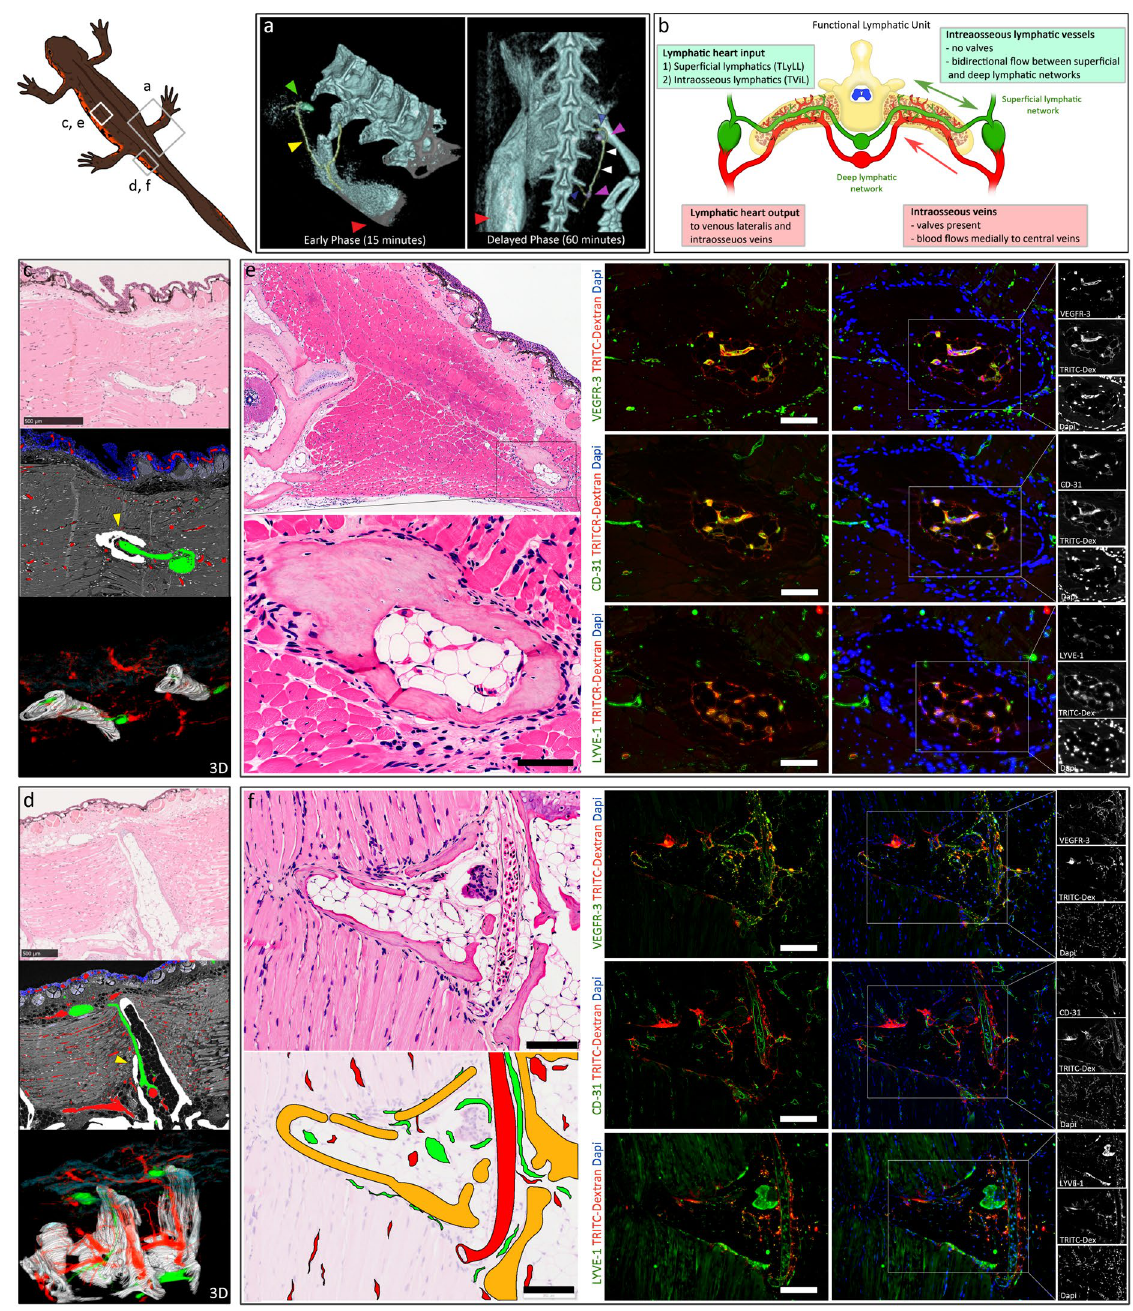
Figure 3. Newt microcirculation and the intraosseous bone marrow lymphatic network. ( a ) Micro-CT Lymphangiography showed movement of contrast injected in the left hindlimb (red arrowhead) flowed through collectors (yellow arrowheads) to the lymphatic hearts (LH) (green arrowhead) and into the vertebral bone to the contralateral collectors (blue arrowhead), contralateral LHs (magenta arrowheads) and the trunci lymphatici longitudinales lateralis (TLyLL) (white arrowheads). ( b ) The functional lymphatic unit repeated throughout the trunk of the newt. The LH input from the superficial lymphatic network via the TLyLL and the transverse vertebral intraosseous lymphatics (TvIL) connecting the deep lymphatic network to the superficial lymphatic network and LHs on both sides of the body. ( c ) and ( d ) Serial section computer 3D volume reconstruction showing the lymphatic vessels (green) and blood vessels (red). The TvIL (yellow arrowheads) are shown flowing from the bone to the LHs. The anterior LHs of the trunk ( c ) were more closely attached to the adjacent rib bone while in the tail ( d ) they were separated from the bones by skeletal muscle. ( e ) and ( f ) Immunohistochemistry showing intraosseous lymphatic vessels and blood vessels in the bone marrow of the transverse process of an abdominal rib (Scale bars = 100 μm) ( e ) and the tail vertebra (Scale bars = 200 μm) ( f ). Lymphatic endothelial cells were identified by high rhodamine-dextran uptake and VEGFR-3 + , LYVE-1 + , CD-31 + staining while blood vessel endothelial cells were CD-31 + , LYVE-1 ± , VEGFR-3- and low rhodamine-dextran